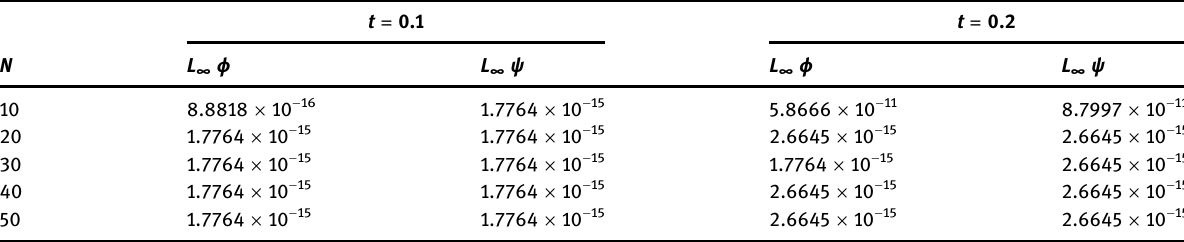
Table 4: L ∞ errors of ϕ and ψ components at di ff erent grid points regarding Example 2 t = 0.1 t = 0.2